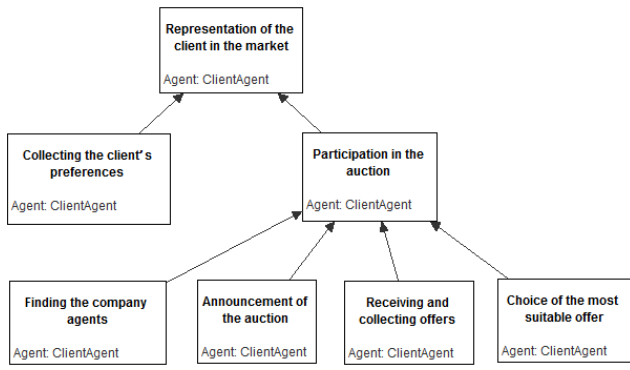
Fig 3. The task hierarchy of the client agent.